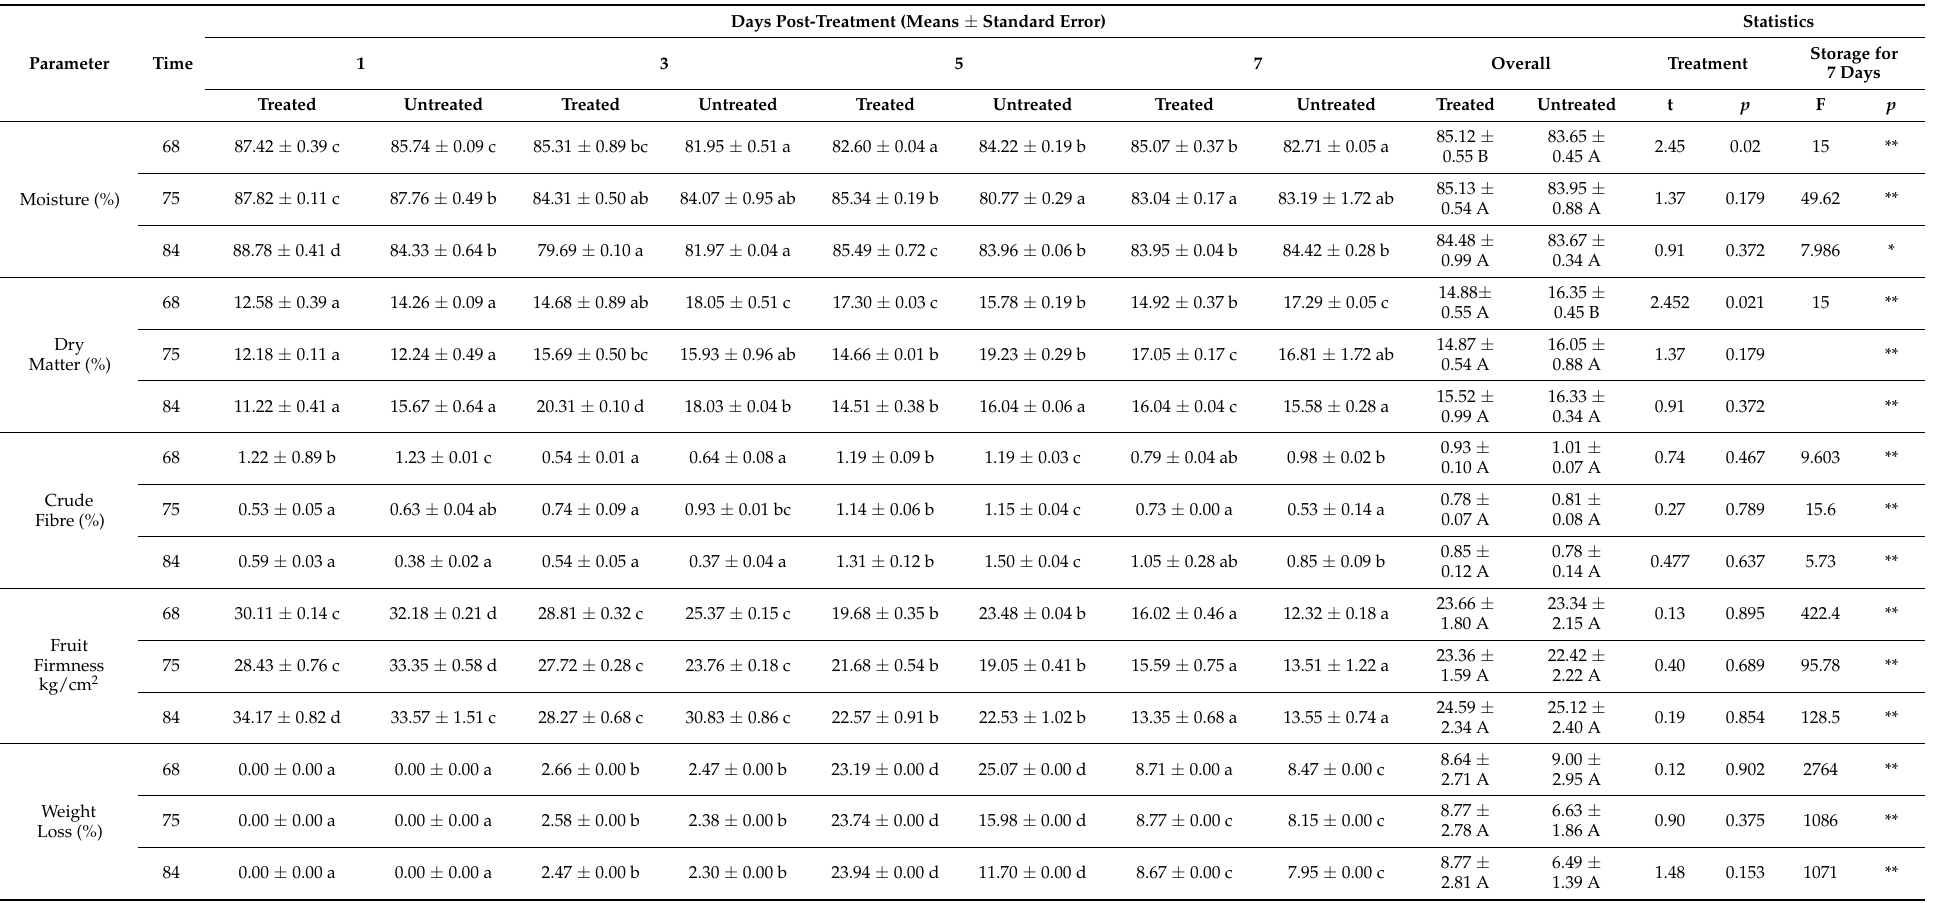
Table 6. Effect of hot water treatment at 46.1 ◦ C for different treatment durations on physical properties of Apple mango cultivar stored over 7 days